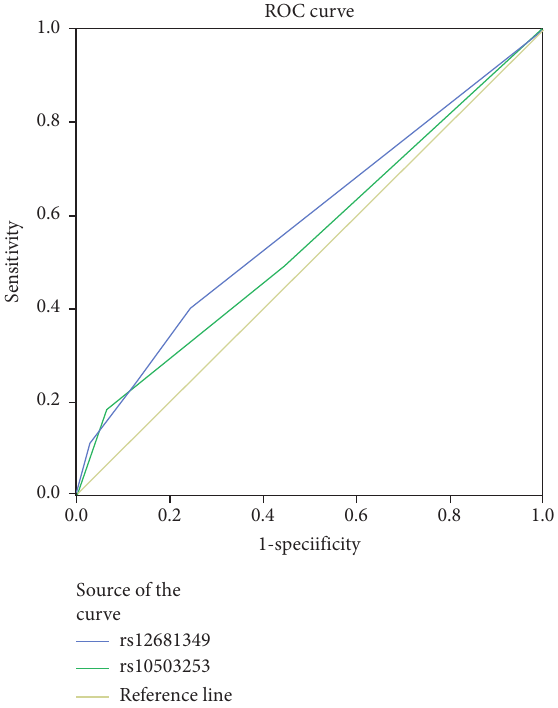
Figure 3: ROC for rs12681349 and rs10503253 in the diagnosis of Parkinson’s disease were compared. ROC: receiver operating curve, p value based on z statistics. p > 0 . 05 was considered as significant. Curve toward upper left corner indicates better performance. Table 8: Results of false-positive report probability analysis for significant